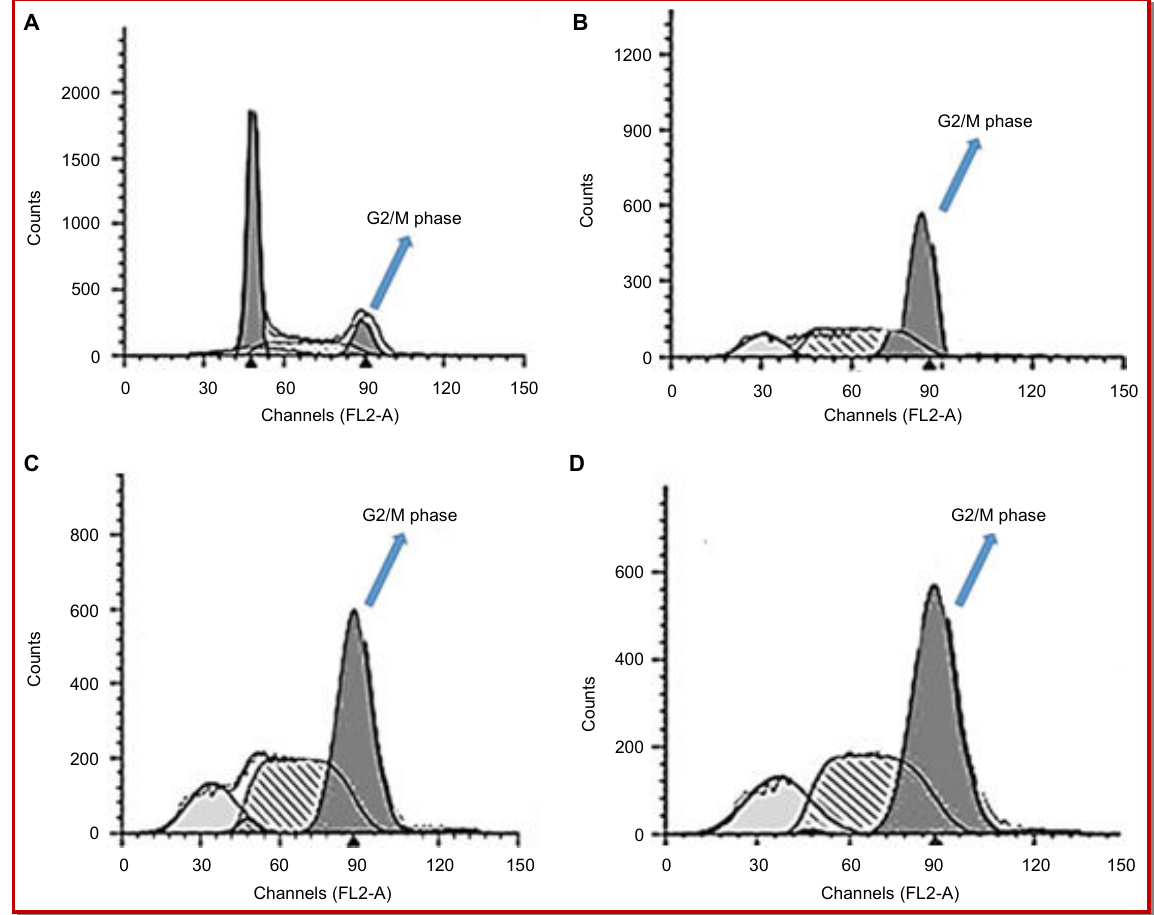
Figure 3: Syringin induces G2/M cell cycle arrest in HeLa human cervical cancer cells. The cells were treated with 0 (A), 10 (B), 50 (C) and 100 µM (D) of syringin for 48 hours, stained with propidium iodide and then analyzed using flow cytometry. The cell population of G2/M phase shows a significant increase with increasing dose of